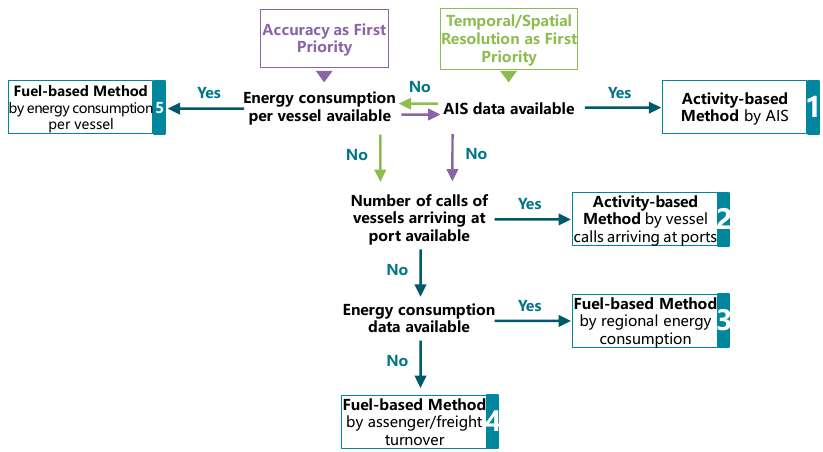
Figure 3. Methods for medium/small-scale inventory compilation.